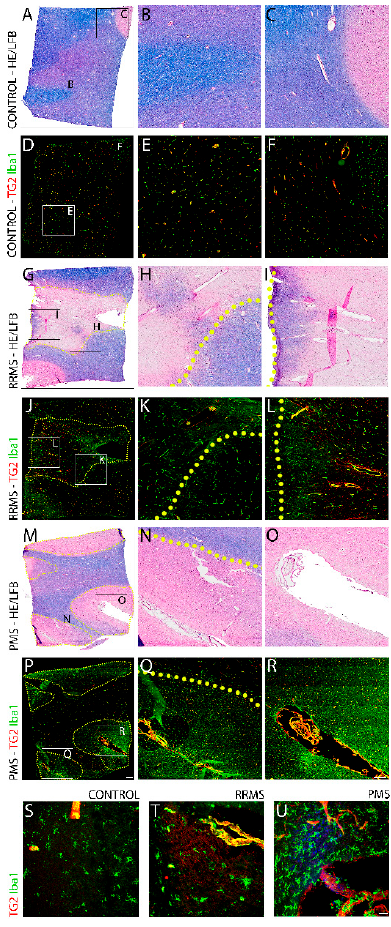
Figure 1. Comparative gross pathology of cortical lesions after RRMS and PMS . Brain tissue sections from control non ‐ MS ( A ) and after RRMS ( G ), and PMS ( M ) were stained with Hematoxylin, Eosin, and Luxol Fast Blue ( A , G , M ) to delineate white matter perivascular lesions with demyelination. An adjacent tissue section from each sample was subjected to immunohistochemistry ( D , J , P , respectively) using antibodies towards TG2 (Red) and the macrophage ‐ microglia specific marker Iba1(Green). Scale bars = 1000 μ m. Close up views of specific regions of H&E/LFB stained section ( A , G , M ) are shown in ( B , C , H , I , N , O ), respectively, while close up views of specific regions of Iba1 and TG2 immunostained sections of ( D , J , P ) are shown in ( E , F , K , L , Q , R ), respectively. Magnified views of microglia and macrophages can be seen in Iba1+/TG2 double stained brain sections from control ( S ), RRMS ( T ), and PMS ( U ) patients. The control tissue from non ‐ MS patients shows a microglial morphology of a typical resting phenotype that is highly branched and has small cell bodies. Stained section from RRMS patients showed microglial cells with an activated phenotype surrounding active lesions with the cells having an ameboid morphology with larger cell bodies and short processes. Tissue sections from PMS patients showed highly dense regions of activated microglia within and around active lesions exhibiting shorter processes and larger cell bodies. The density of activated microglia and macrophages surrounding active lesions in tissue sections from PMS patients appeared significantly higher than that from RRMS patients.